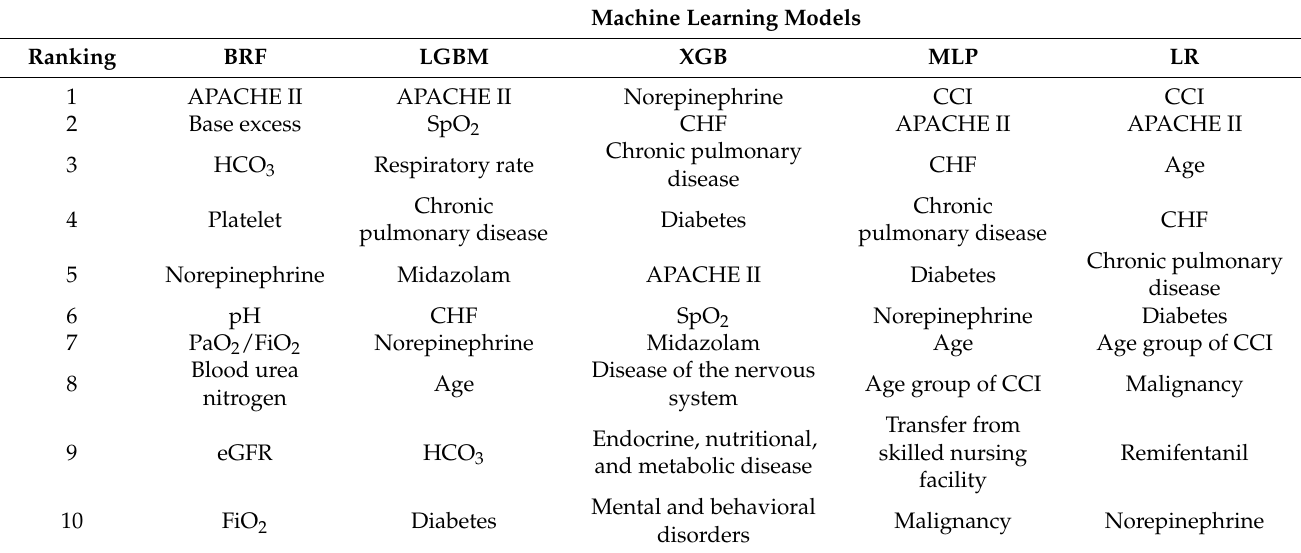
Table 3. Top 10 most important variables for predicting 30-day mortality in the machine learning models. Machine Learning